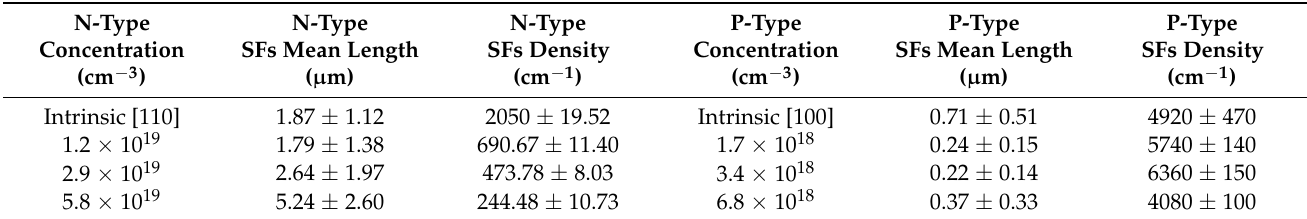
Table 1. Values of average lengths and densities for different doping